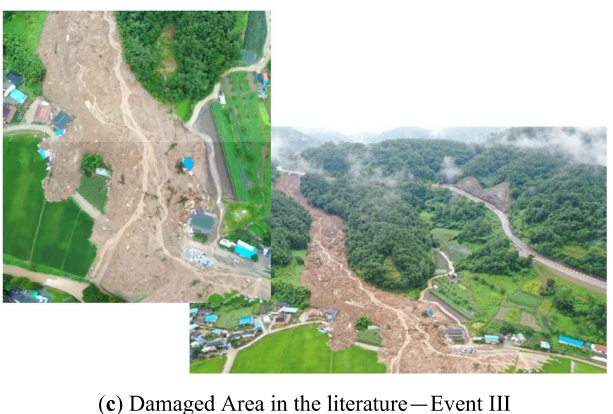
Figure 16. Damaged area in the literature. ( a ) is the 2019 Landslide Investigation Report, ( b ) is drone video and photos taken by Kwon Wu-seong, and ( c ) is the status of each debris flow area referring to the article by reporter Jin Chang-il of the JoongAngIlbo.